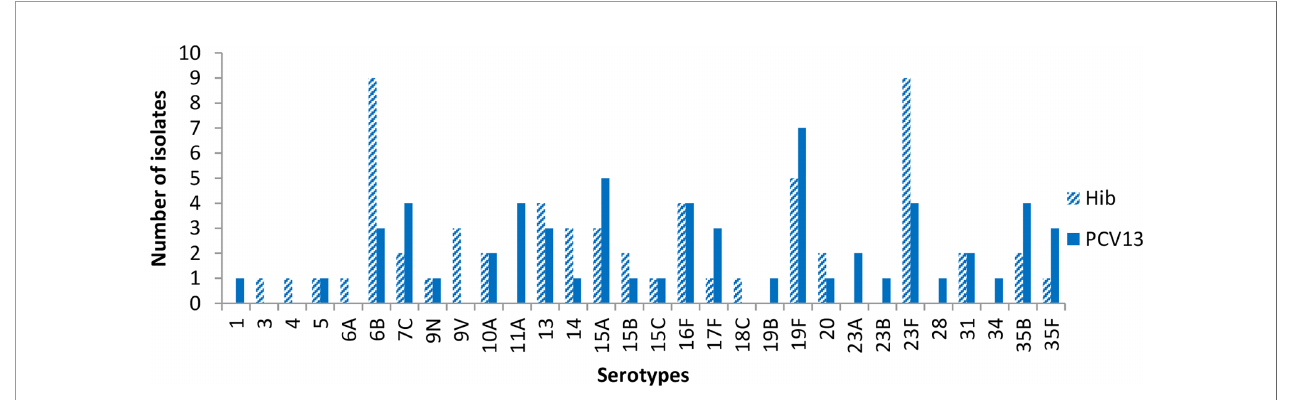
FIGURE 3 | Pneumococcal serotype isolated at 4-6 months post